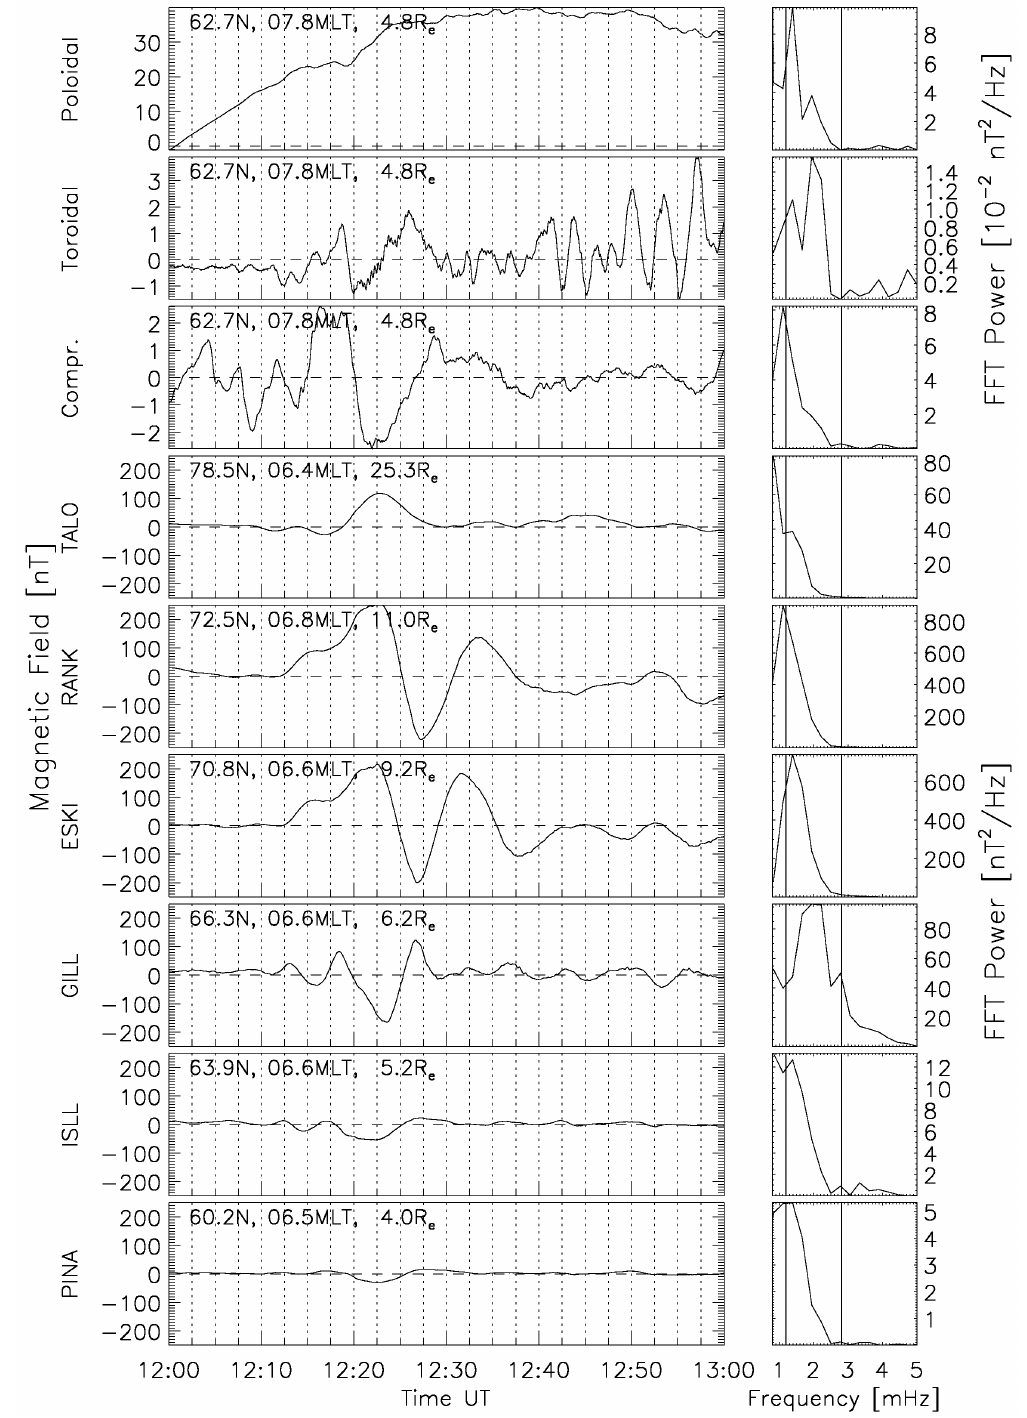
Fig. 8. The top three panels show magnetic field measurements by s/c 4 in the T96 field-aligned coordinate system. Ground-based magne- tometer data from stations along a latitude profile of CARISMA stations are shown in the bottom seven panels. The panels on the right give the respective Fourier spectra. All data are from 12 November